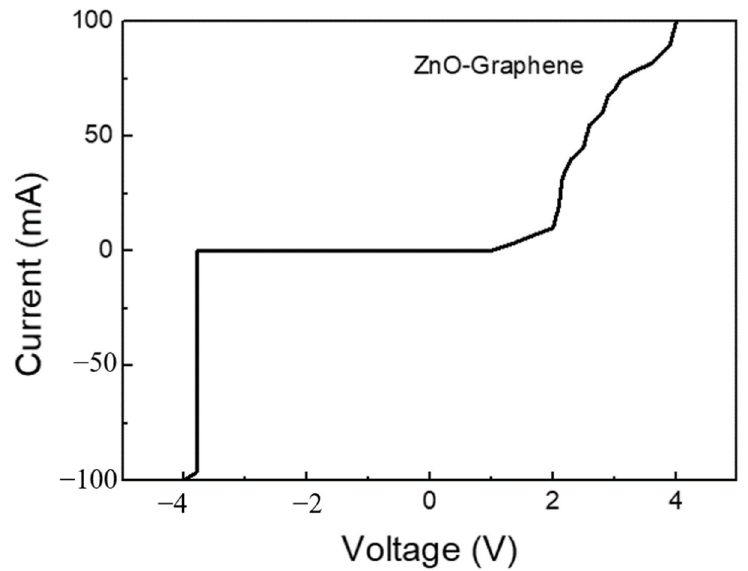
Figure 10. The I–V electrical character of graphene/zinc oxide nano-heterostructure.